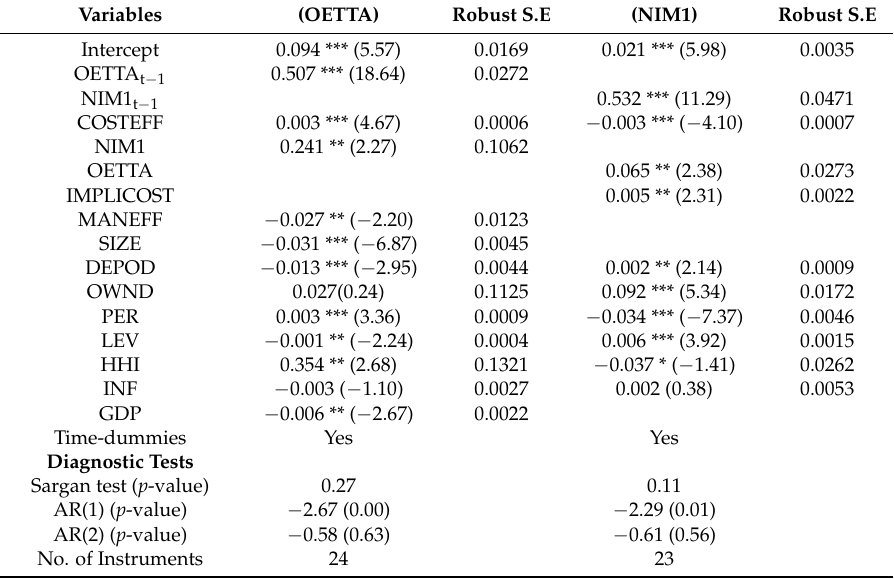
Table 7. Impact of Cost Efficiency on Bank Capital and Intermediation Cost (Balanced Panel